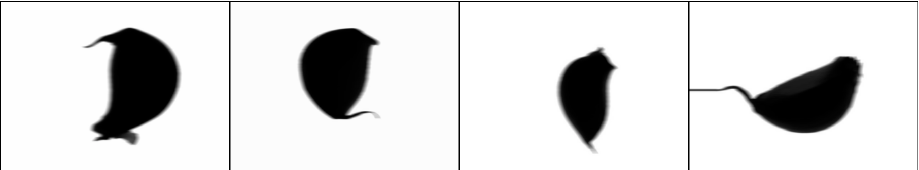
Figure 8. Samples of each orientation class.